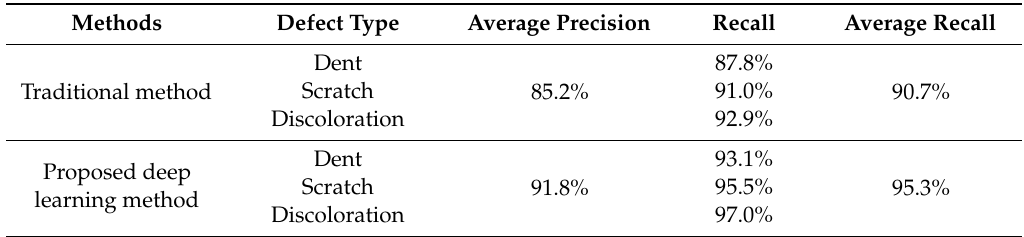
Table 1. Precision and recall results of the traditional machine vision method and proposed deep learning